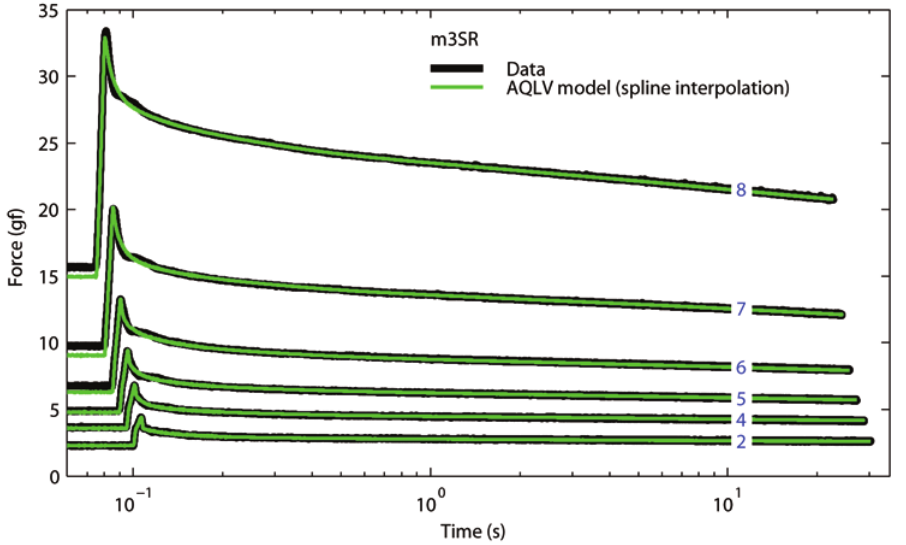
Figure 6. Step responses and AQLV model fits. Data (black) and force predicted by the AQLV model (green). The values for the parameters of the model at each step length were derived from the parameters of the generalized QLV model described above. A cubic spline interpolation (Fig. 7C) was then used to determine the value of the parameters at other lengths. Data for the superior rectus in m3. Each step has been offset in time for clarity. Note that in a logarithmic plot to carry out this operation without deforming the shape the time axis must be compressed, not shifted.